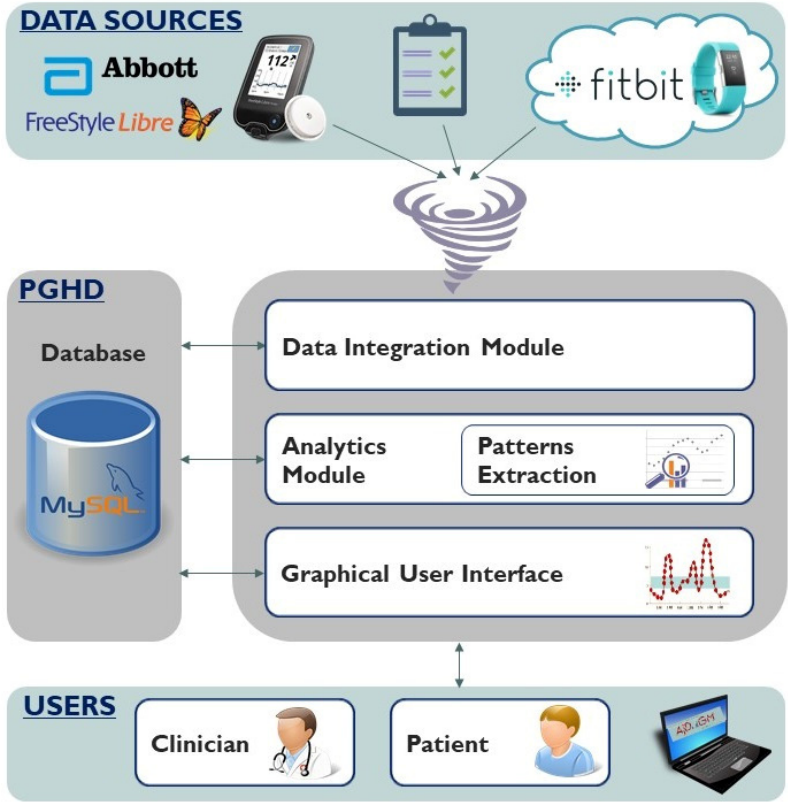
Figure 1. The AID-GM Figure 1 . The AID-GM architecture.